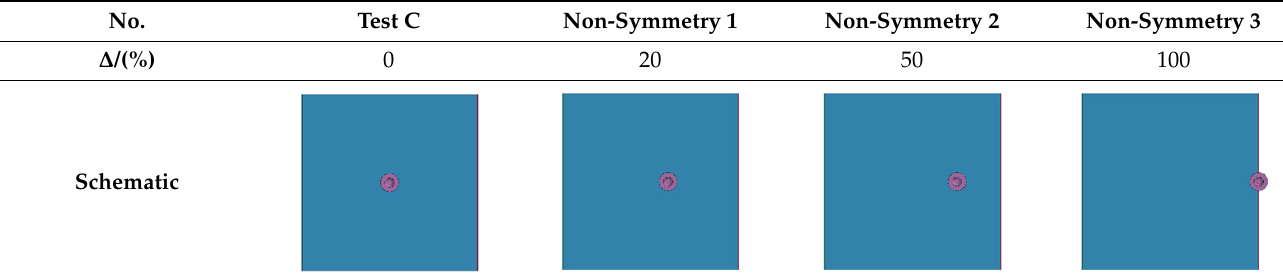
Table 8. Simulation conditions.